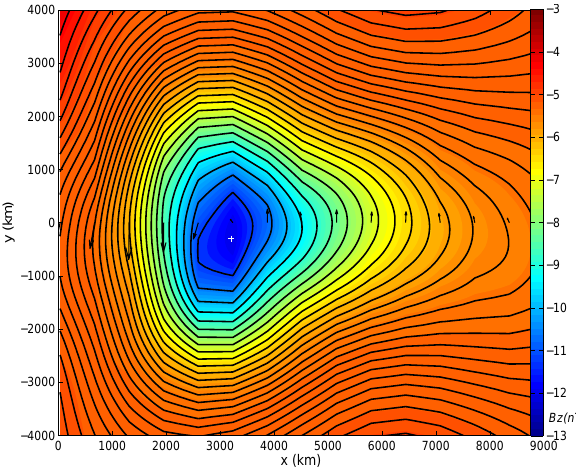
Fig. 3. The reconstruction results of the flux rope on 11 October 2003. The closed black curves are the contour plots of the magnetic potential A on the cross section X-Y plane, which are just the mag- netic field lines projected onto the cross section. The filled color inside the curves displays the distribution of the field component B z along the principal axis. The plus at the center of the figure de- notes the maximum of the axis field B z . The black arrows along the Y axis in the figure are the measured magnetic vectors (not include the axis field B z